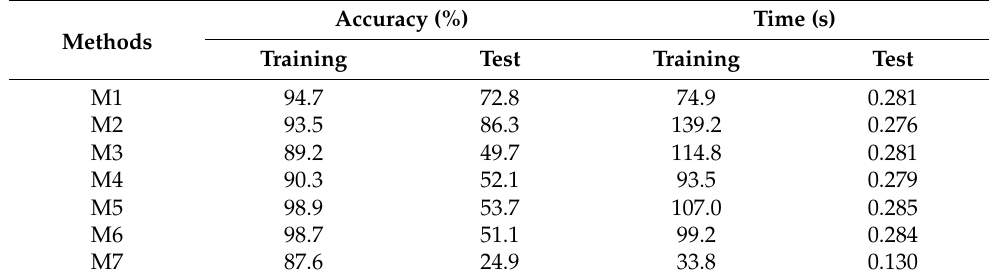
Table 2. Training and testing results for each model when using only 200 target domain samples.